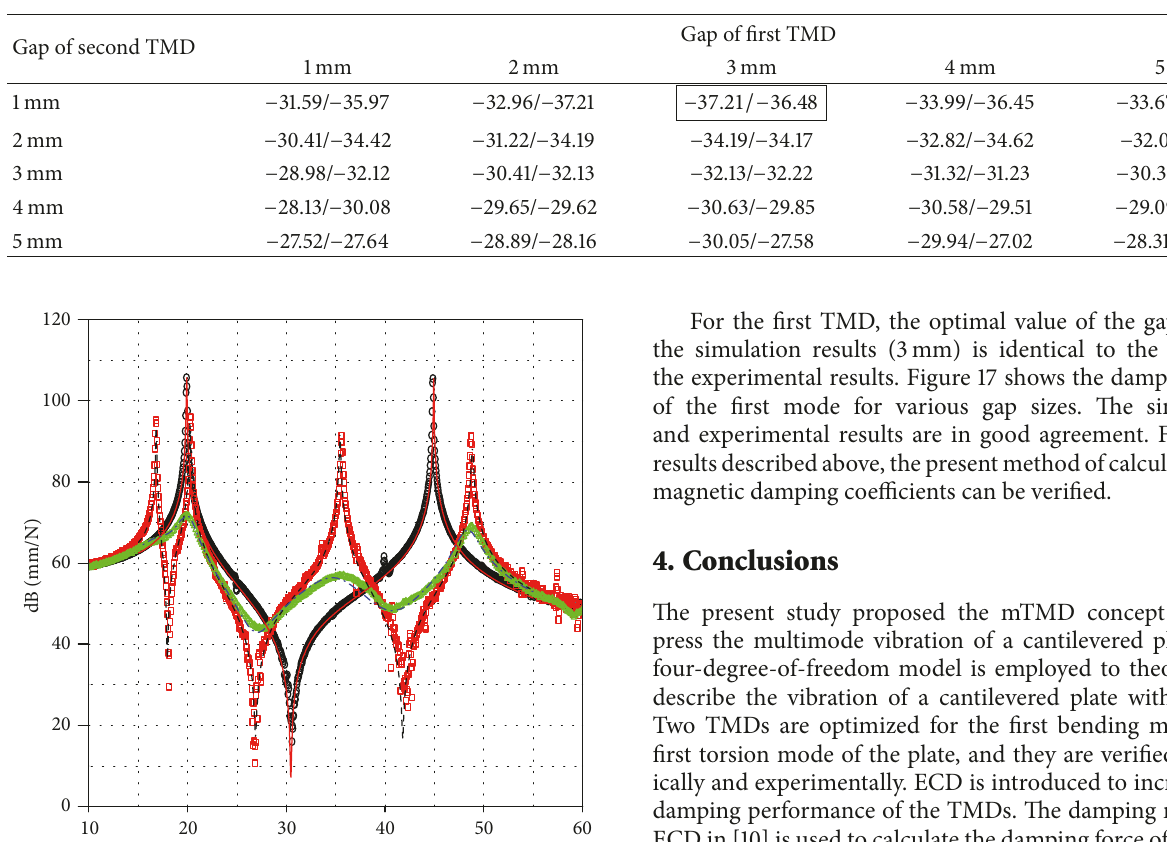
Figure 14: Experimental setup of the mTMD. Table 2: Experimental results of the mTMD with respect to gap interval [Unit: dB].